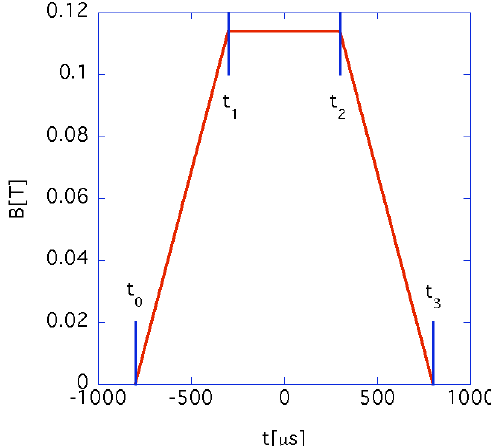
FIG. 13. (Color) The behavior of the bump magnet flux B ð t Þ (analytical data). This is characterized by rising time ð¼ (cid:1) 300 (cid:5) s Þ (cid:1) t t 1 ð¼ (cid:1) 300 (cid:5) s Þ , and damping time t t 1 ð¼ 300 (cid:5) s Þ . t 2